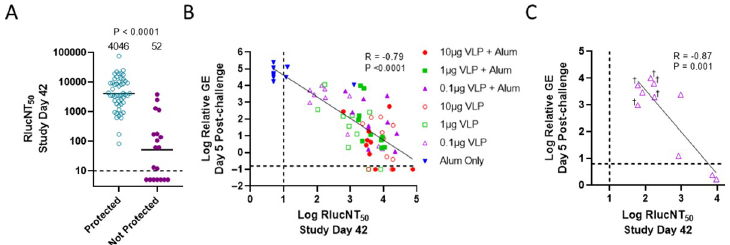
Fig 5. Neutralizing antibody levels induced by ZIKV VLP vaccination correlates with protection. (5A) Comparison of Day 42 RlucNT 50 titers in mice that survived (Protected) or died (Not Protected) after lethal ZIKV challenge. GMTs is shown by bars, individual titers by symbols, and assay LOD by dashed line. Significance value shown is from Mann- Whitney U test. (5B) Correlation of Day 49 (day 5 post-challenge) relative ZIKV GE compared to Day 42 RlucNT 50 titers for all groups. (5C) Correlation of Day 49 (day 5 post-challenge) relative ZIKV GE compared to Day 42 RlucNT 50 titers for the VLP 0.1 μ g dose group only. Log-transformed values for each serum RlucNT 50 titer and Relative GE RNAemia load (symbols based on immunization group), with dashed lines representing the assay LOD for RlucNT 50 assay (x-axis) or reference level for maximum na ï ve mouse Relative ZIKV GE as in Fig 4 (y-axis) are provided. R and P values as well as regression lines shown were determined by least squares regression